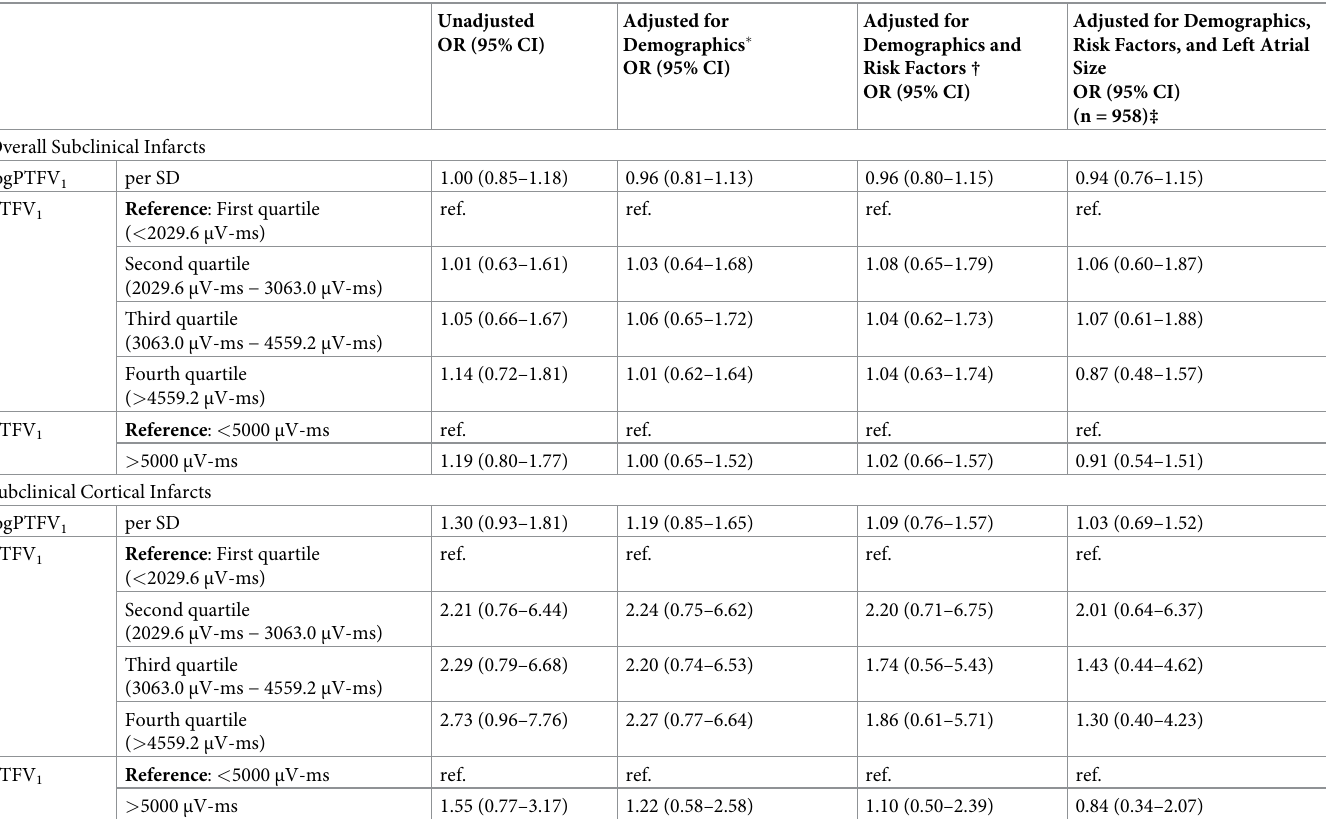
Table 2. Association between P-wave terminal force in lead V 1 (PTFV 1 ) and risk of Subclinical Cerebral Infarcts (n =